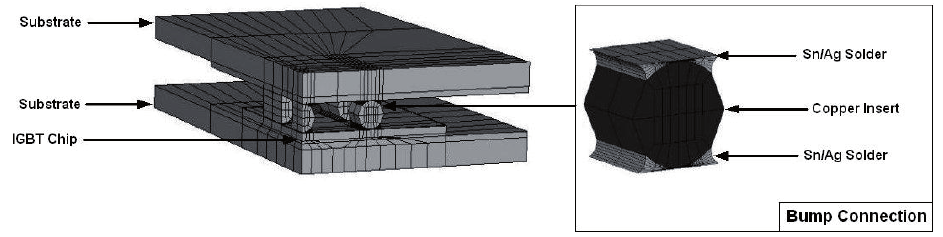
Fig. 2. The 3-D finite element